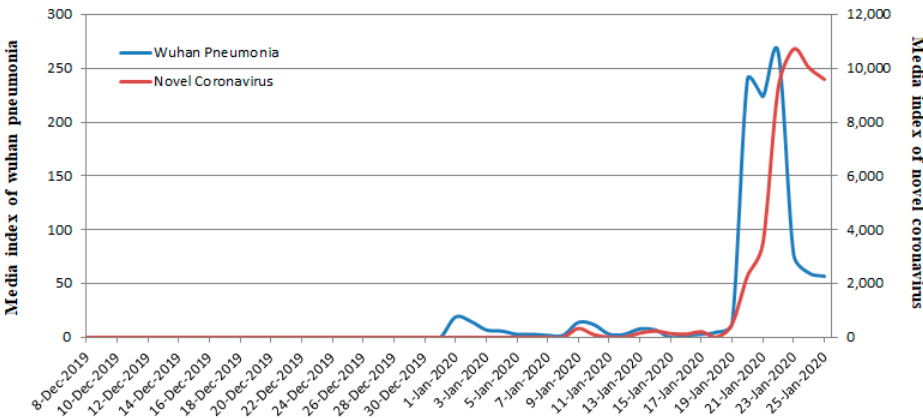
Figure 1. Frequency of the media keywords “Wuhan pneumonia” and “Novel Coronavirus” from 8